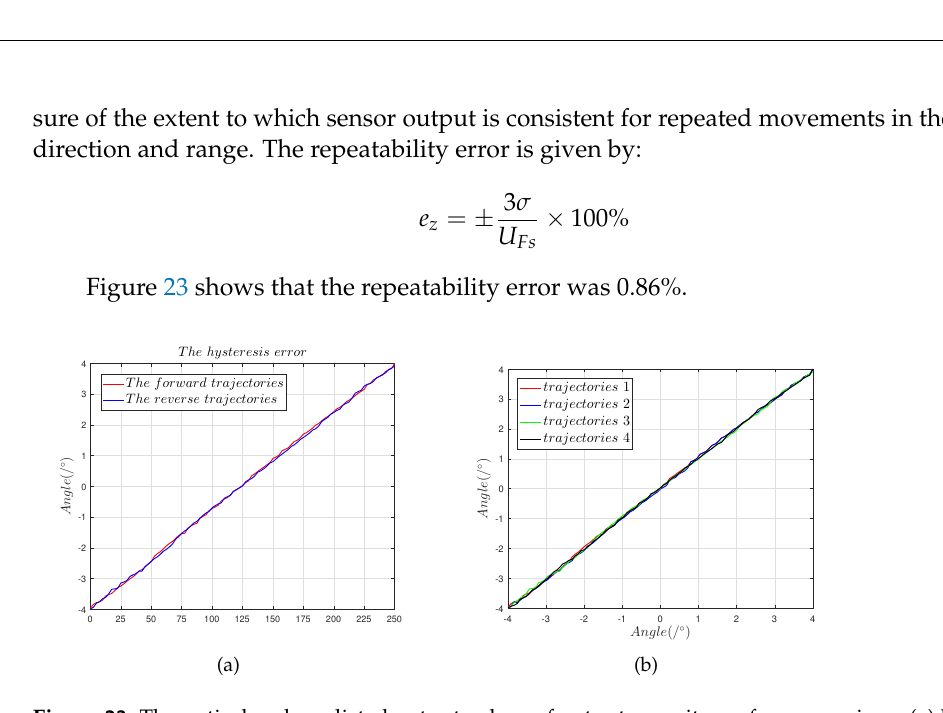
Figure 23. Theoretical and predicted output values of output capacitance for comparison: ( a ) hystere- sis error in the 45° direction; ( b ) repeatability error in the 45° direction.